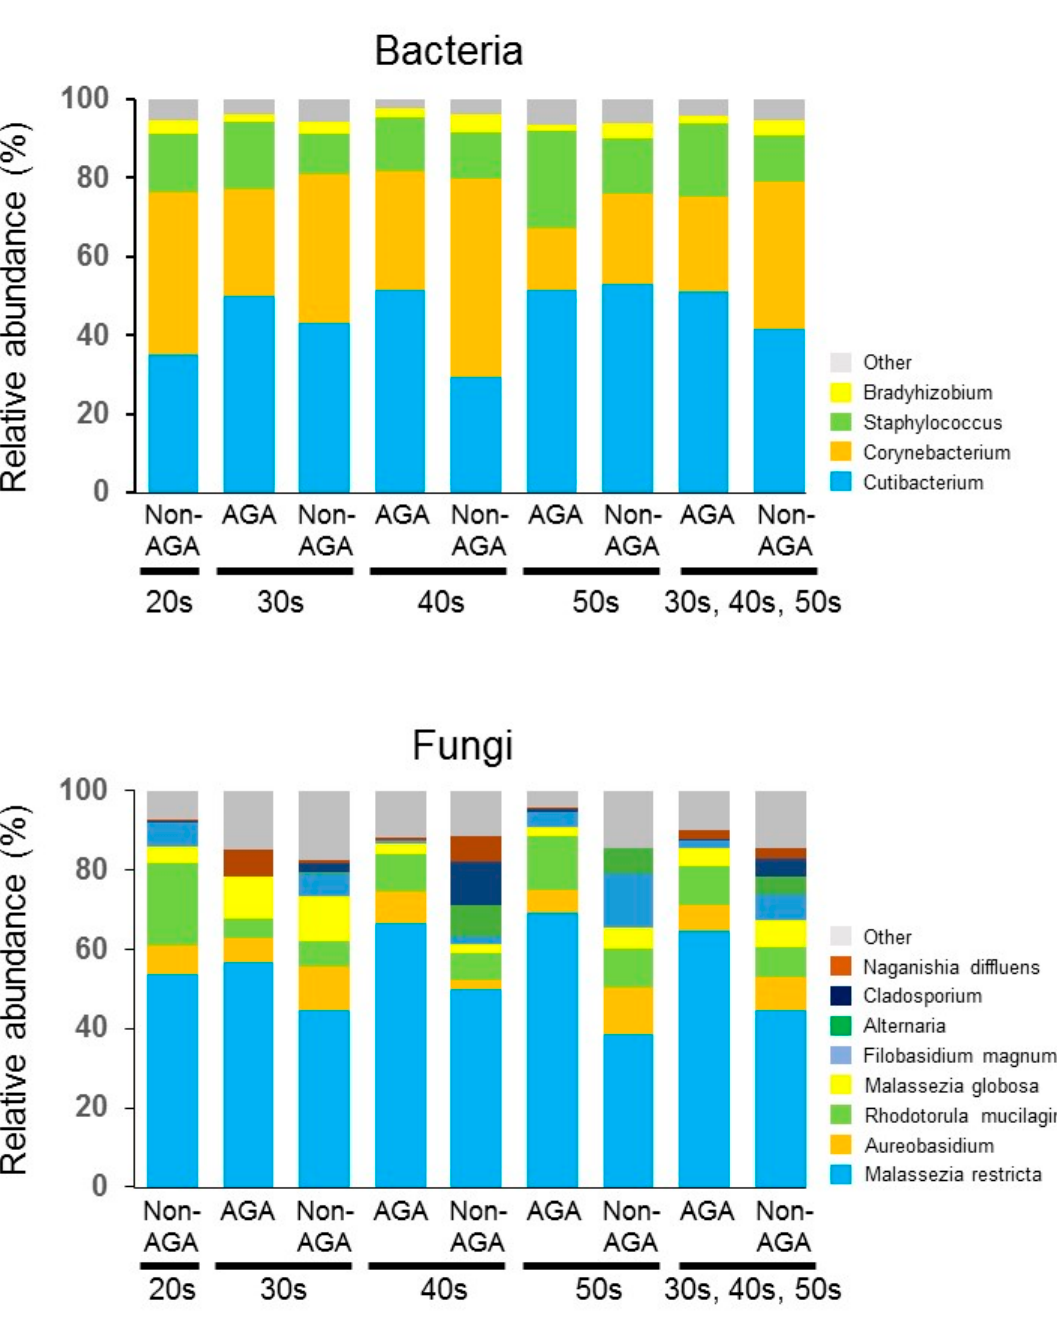
Figure 1. Mean relative abundances of the top four most abundant bacterial and fungal taxa (>5% abundance) in scalp samples from AGA and non-AGA groups by age group (20s, 30s, 40s, and 50s). There was a higher abundance of Cutibacterium and Staphylococcus and lower abundance of Corynebacterium in the AGA group than in the non-AGA group. In the fungal microbiome, Malassezia restricta predominated at all ages in the AGA and non-AGA groups .